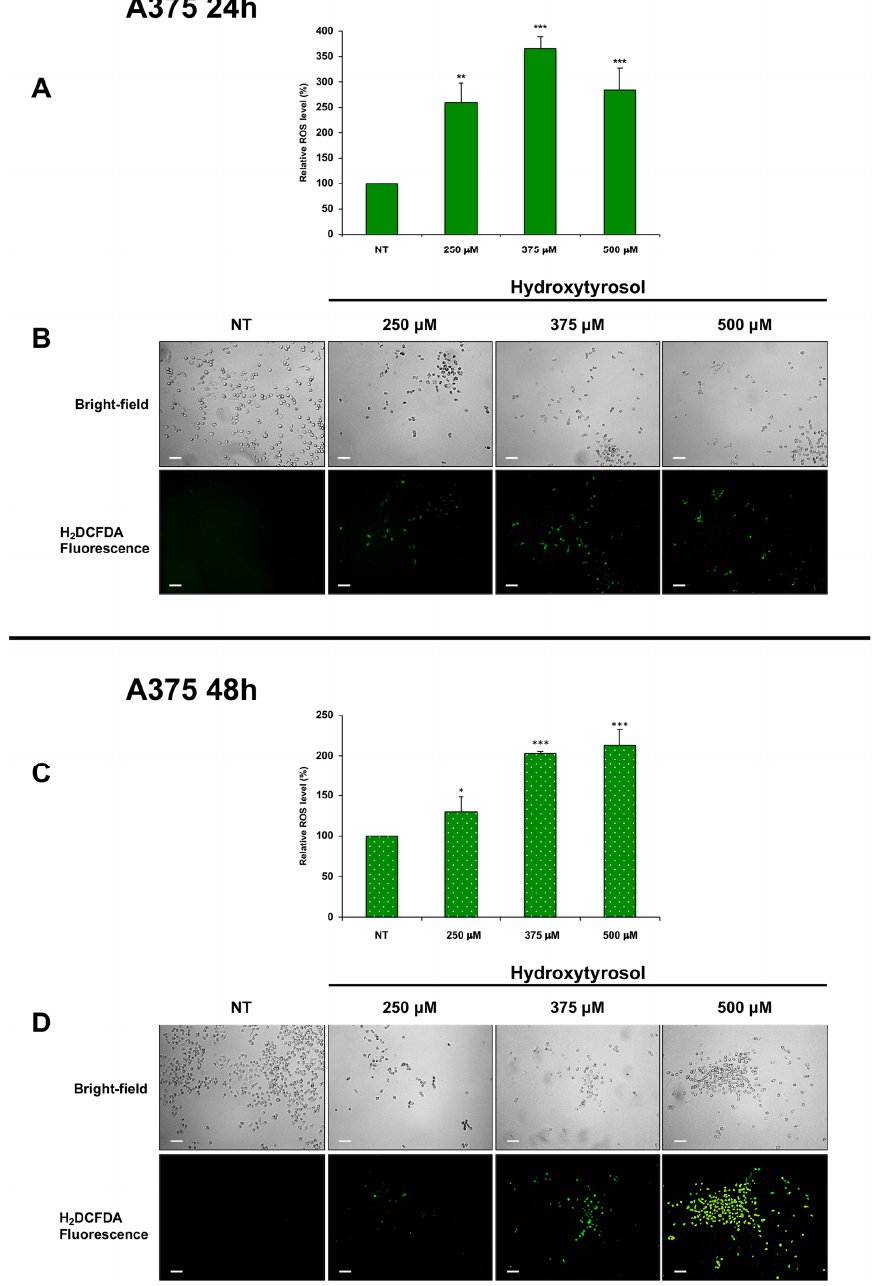
Figure 8. Amount of ROS in A375 cells treated with hydroxytyrosol. A375 melanoma cells were treated with 250 µ M, 375 µ M, and 500 µ M of hydroxytyrosol for 24 h ( A , B ) and 48 h ( C , D ). The green-fluorescent emission of DCF was quantified ( A , C ) and was analysed ( B , D ) through an inverted fluorescence microscope. The intensity of fluorescence that is directly proportional to hydrogen peroxide concentration was reported in the histograms ( A , C ) as the mean values of ROS acquired from almost three di ff erent experiments performed in triplicate and is expressed as a percent of ROS produced in unstimulated cells. The error bars indicate the standard deviation, statistical significance was analysed by Student’s t -test: * p < 0.05 was considered significant; ** p < 0.01 highly significant; *** p ‘ < 0.001 very highly significant. The bright-field and fluorescence photomicrography of treated and untreated A375 cells stained with H 2 DCFDA probe are reported in ( B , D ). Images were acquired with an inverted Leica fluorescence microscope using a × 10 objective. Scale bar: 100 µ m. The images are representative of almost three di ff erent